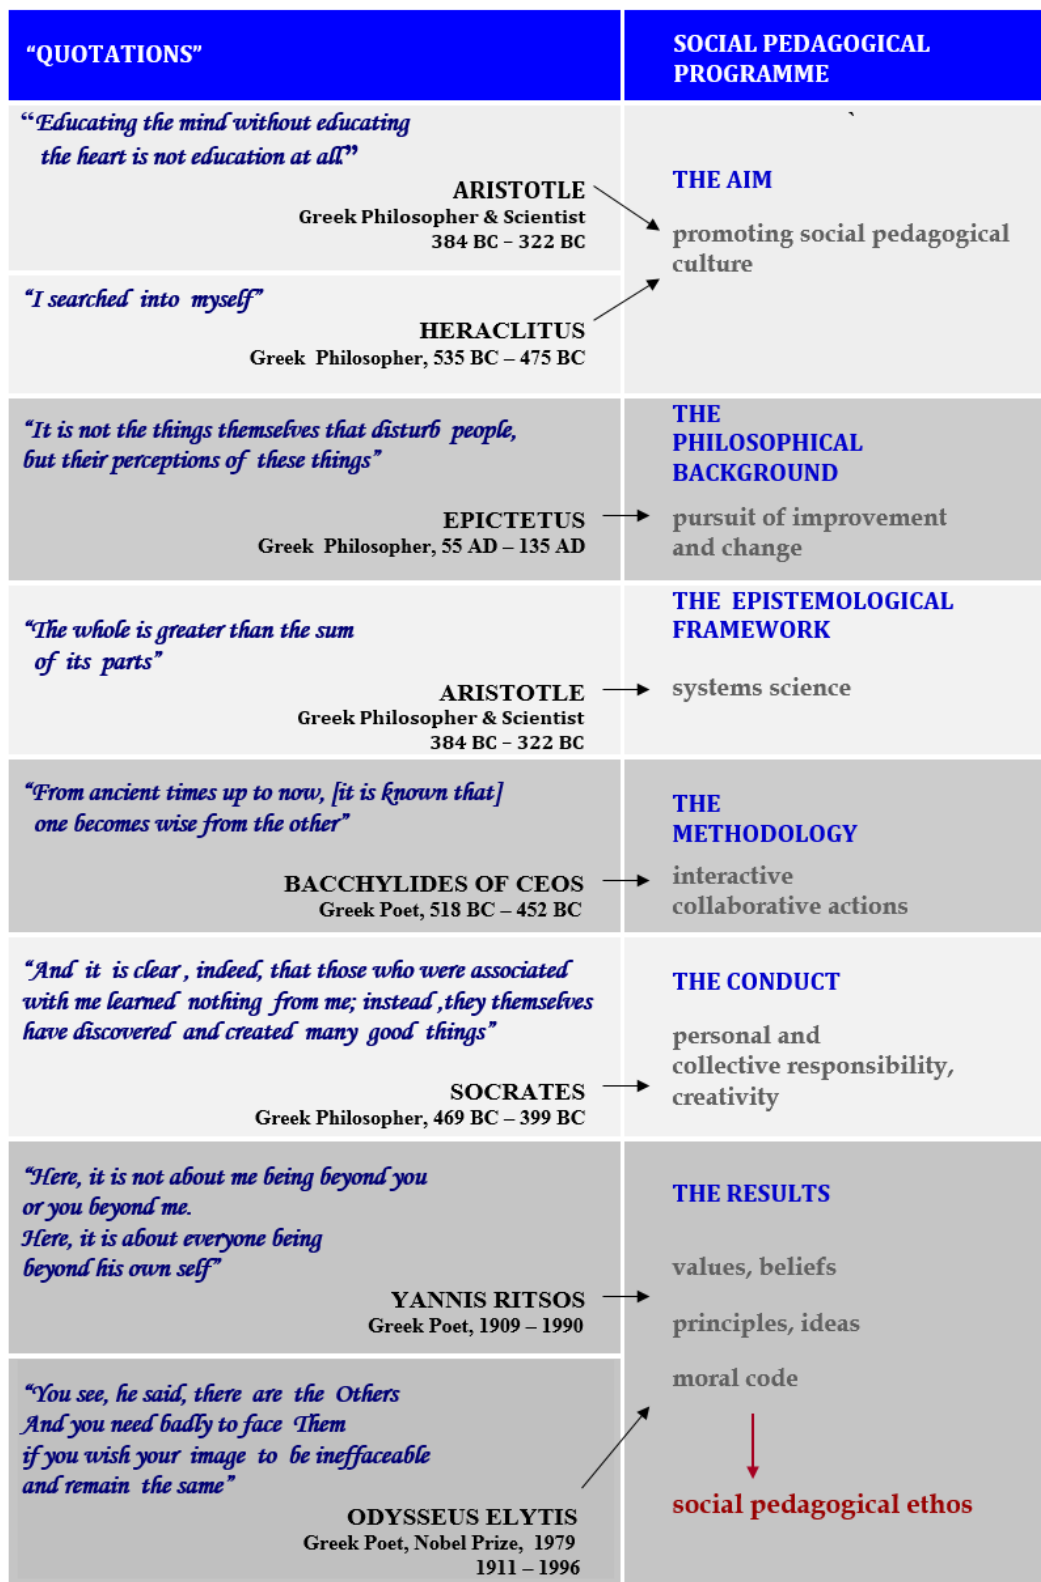
Table I: Diagrammatic representation of the dimensions of the social pedagogical programme through quotations from Greek philosophers and poets from antiquity up to the